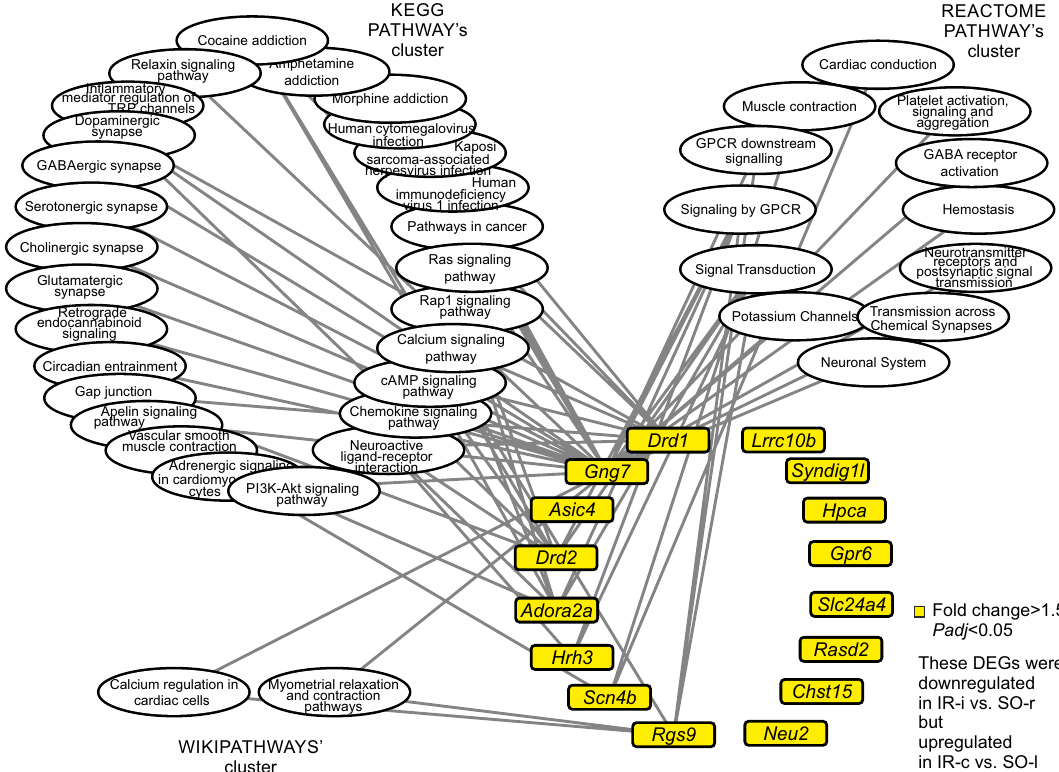
Figure 5. Network showing the involvement of the DEGs that had oppositely changed mRNA levels for the signaling pathways modulated during IR in the two brain hemispheres after tMCAO. The network was constructed using Cytoscape 3.8.2 software. The nodes are designated as the DEGs or signaling pathways. Each line connecting the nodes indicates the involvement of the protein product of the corresponding gene in signaling pathway functioning. All clustered signaling pathways were annotated using KP, RP, and WP databases. The cutoff for mRNA expression changes was 1.50. Only those DEGs and annotations with Padj < 0.05 for each set of DEGs in the comparison IR-i vs. SO-r were selected for